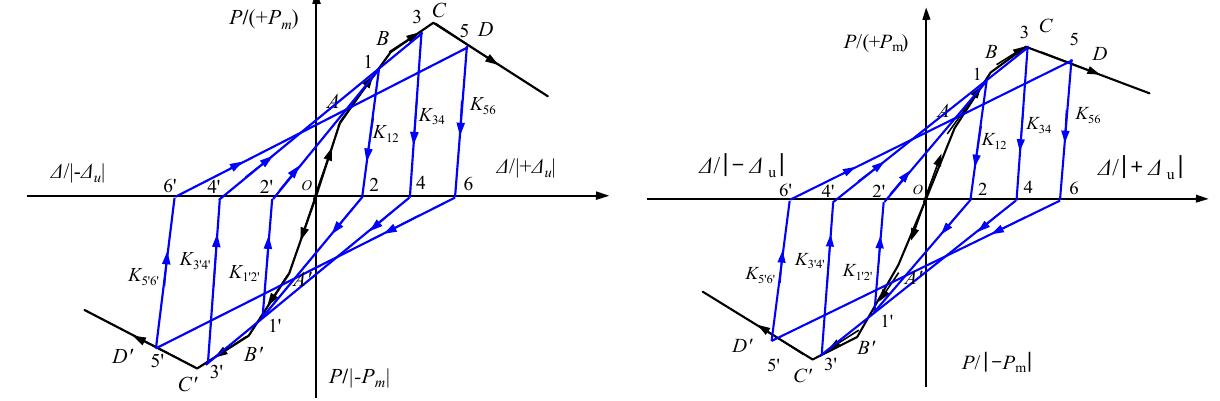
Figure 23. Stiffness degradation rule of specimen.